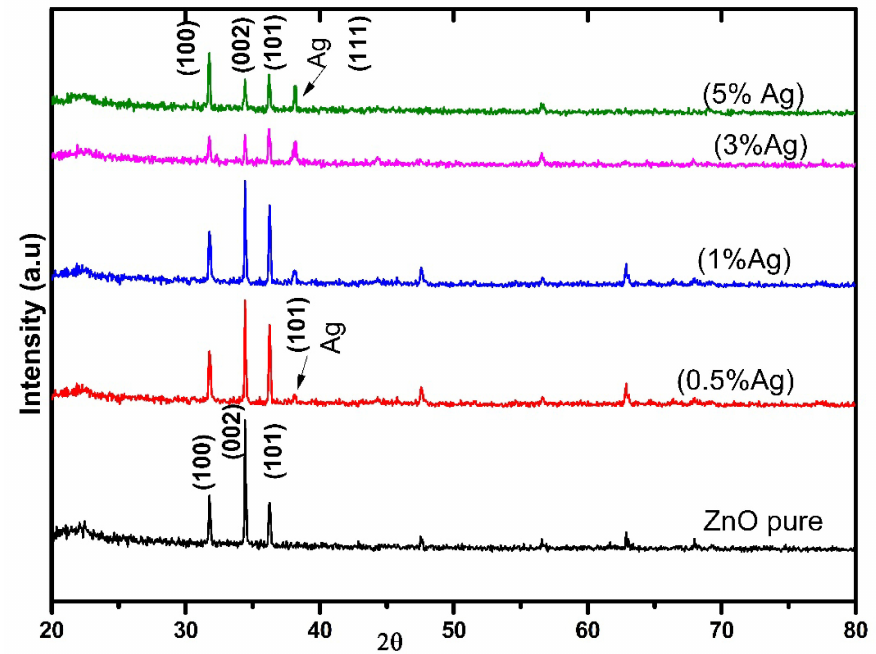
Figure 2. The X-ray diffraction pattern of undoped ZnO and Ag-doped ZnO thin